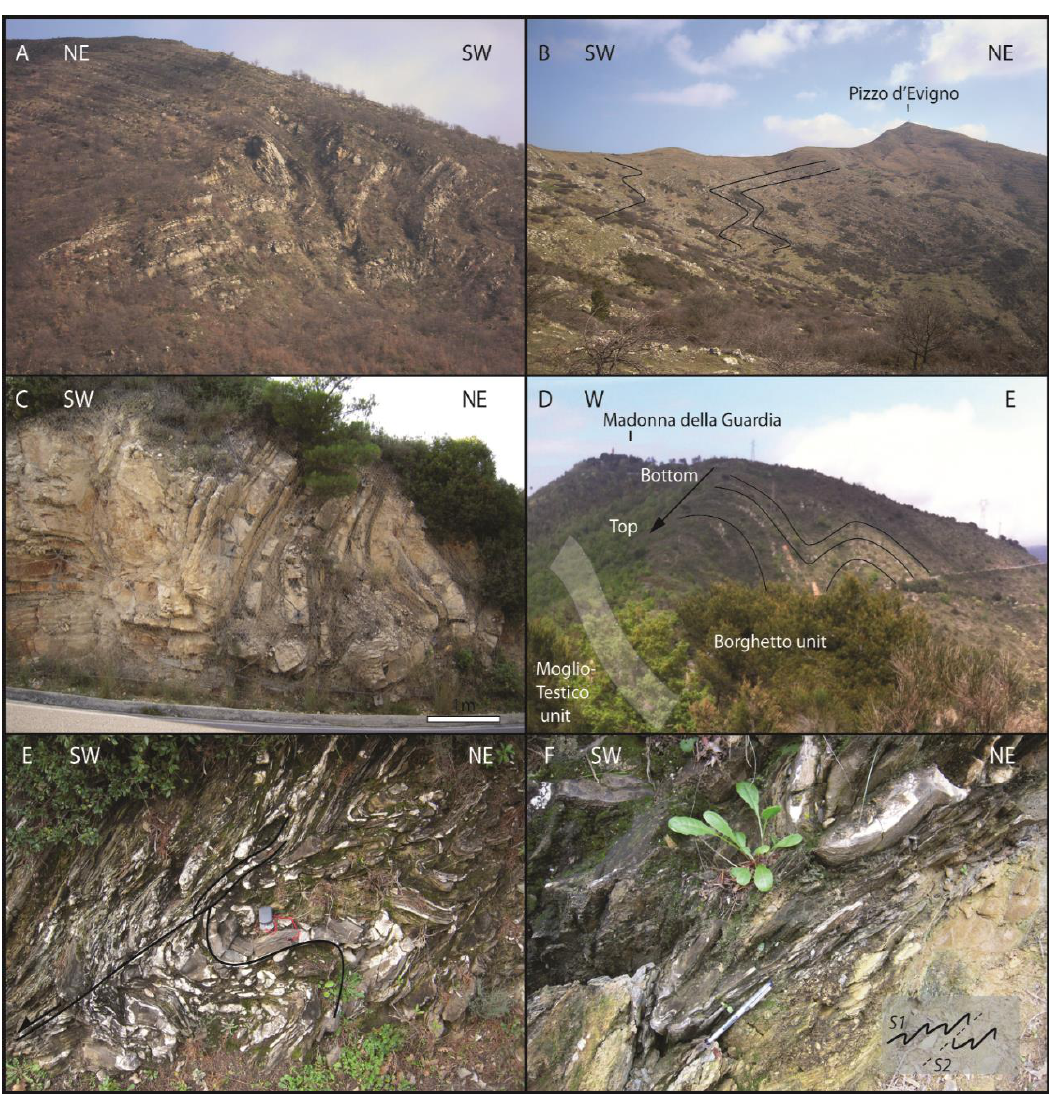
Figure 9. Deformation features from cross-section C-C’. Chevron folding of the carbonate turbidites in the Sanremo unit ( A – C ). The overturned geometry of the contact between the Borghetto and Moglio – Testico boundary ( D ). Foreland-dipping folds strongly crenulated and veined and associated synthetic shear zones ( E ). Top-to-NE brittle shear zones in the Moglio – Testico turbidites ( F ).